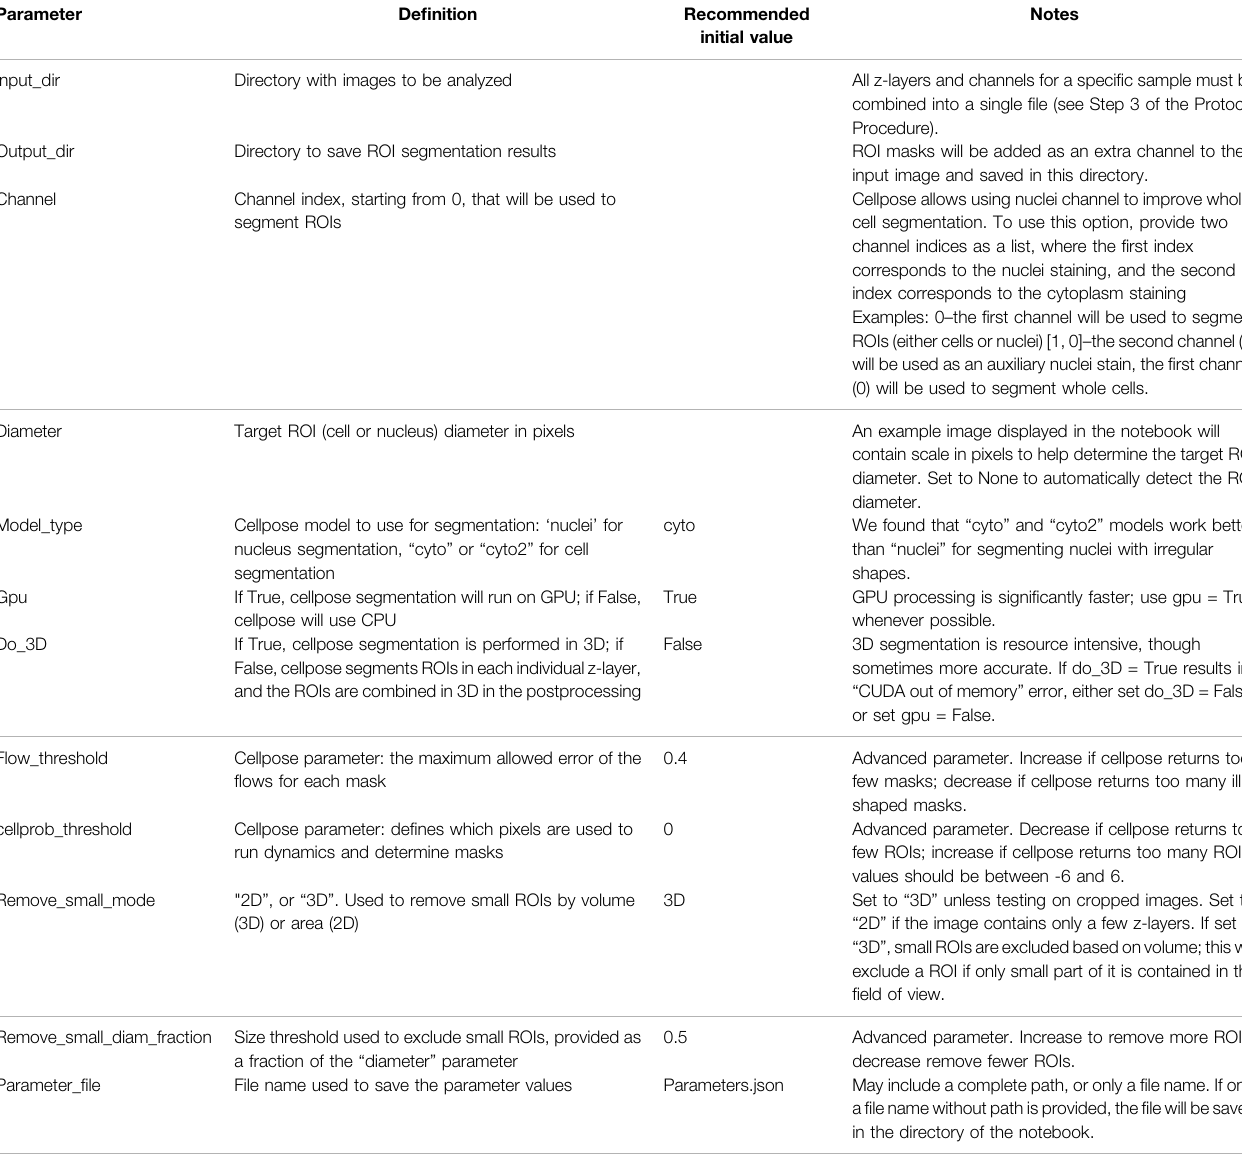
TABLE 1 | List of parameters for ROI segmentation